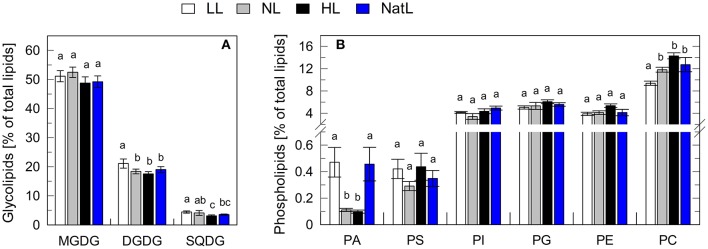
Lipid composition of leaves. (A) Relative amount of glycolipids. (B) Relative amount of phospholipids. MGDG, Monogalactosyldiacylglycerol; DGDG, Digalactosyldiacylglycerol; SQDG, Sulfoquinovosyldiacylglycerol; PA, Phosphatidic acid; PS, Phosphatidylserine; PI, Phosphatidylinositol; PG, phosphatidylglycerol; PE, and phosphatidylethanolamine; PC, Phosphatidylcholine. Mean values ± SD of five independent samples are shown. Significant differences [Holm-Sidak test, p < 0.05, for (A); Dunn's test, p < 0.05, for (B)] are indicated.